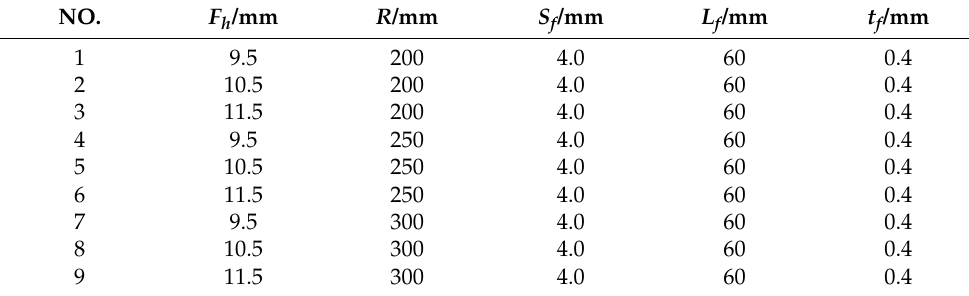
Table 3. Parameter table for circular-arc-shaped flow